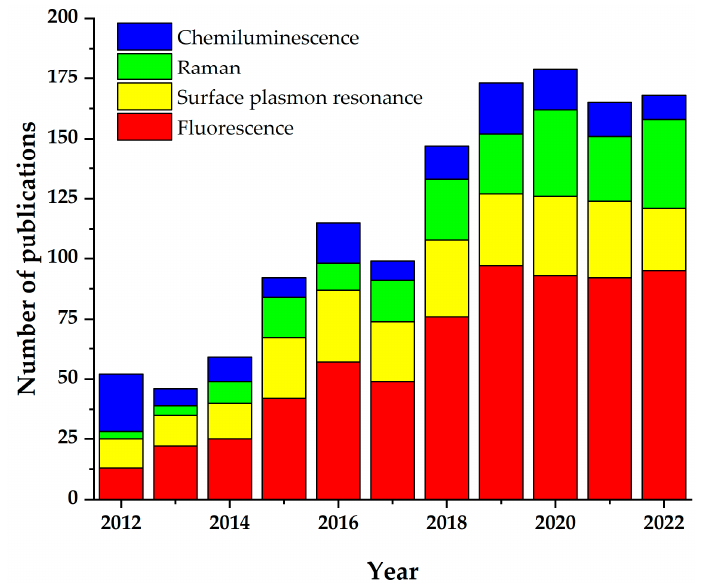
Figure 1. Number of publications with the keywords of molecularly imprinted fluorescence/surface plasmon resonance/Raman/chemiluminescence sensors. The data were collected from January 2012 to December 2022 according to the Web of Science .